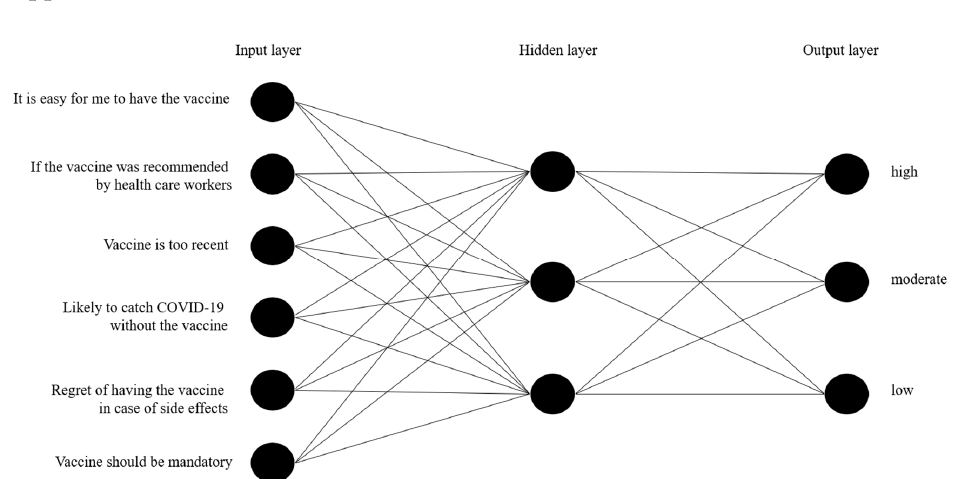
Figure A1. Multi-class artificial neural network (ANN) for predicting COVID-19 vaccination intention.